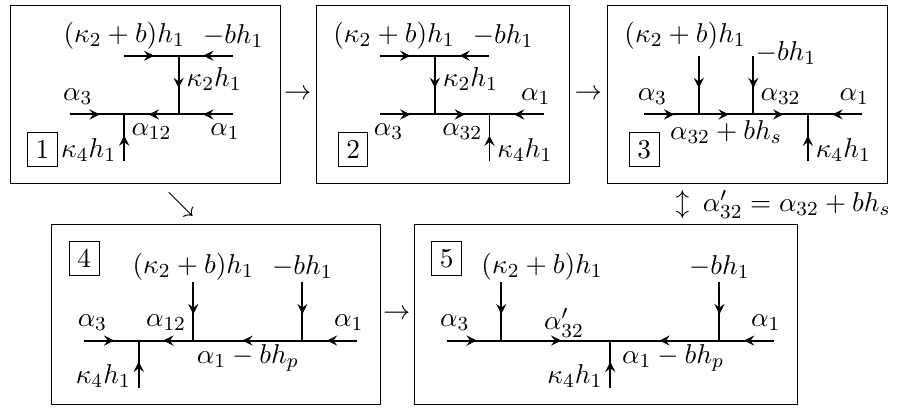
Figure 1 . Pentagon identity. 1 ! 2 and 4 ! 5 are braidings of two semi-degenerates, 2 ! 3 and 1 ! 4 are known fusions of b V (cid:0) bh a